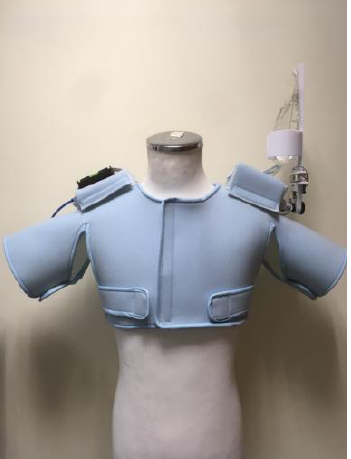
Figure 22. System prototype.